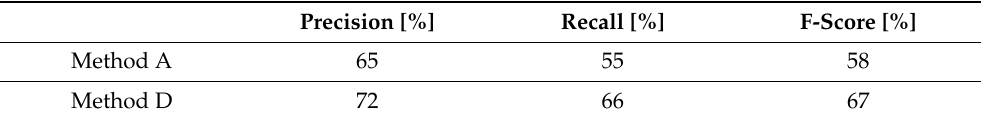
Table 4. Results when the majority answer data are in the top three estimated emotions by Web search.